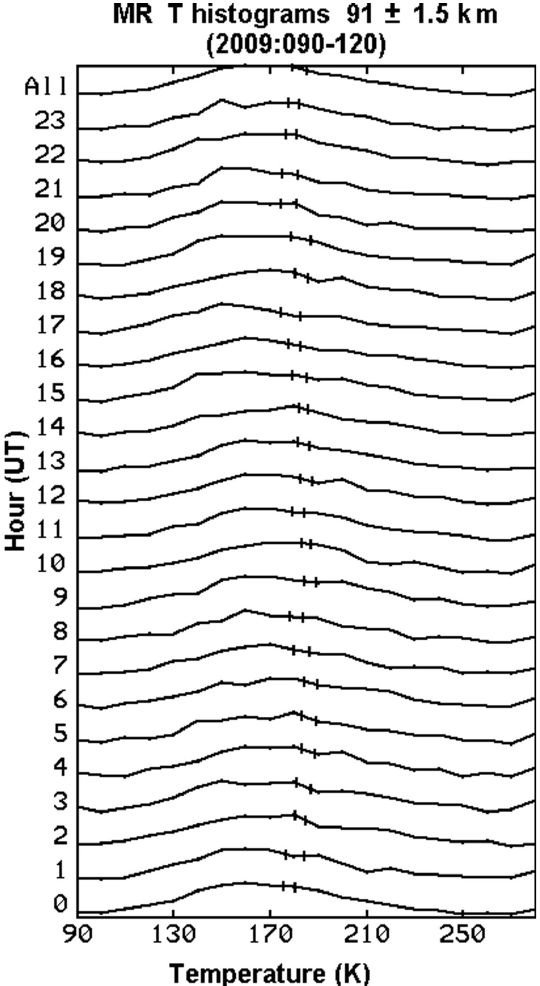
Fig. 6. Illustration of the pressure method: histograms of individual trail temperatures, T , over a month: separate hours and combined (“all”). On each trace the right ticks indicate median T s the left, average T